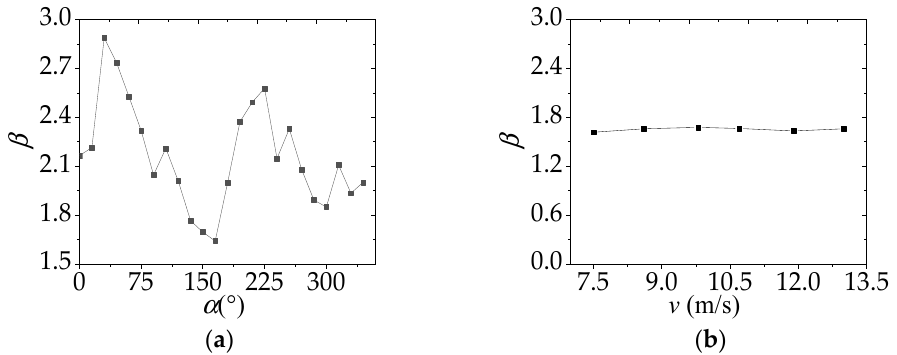
Figure 5. Displacement wind-induced vibration coefficient of the LT among different cases: ( a ) Different wind yaw angles, ( b ) Different wind speeds. ( a ) Different wind yaw angles, ( b ) Different wind